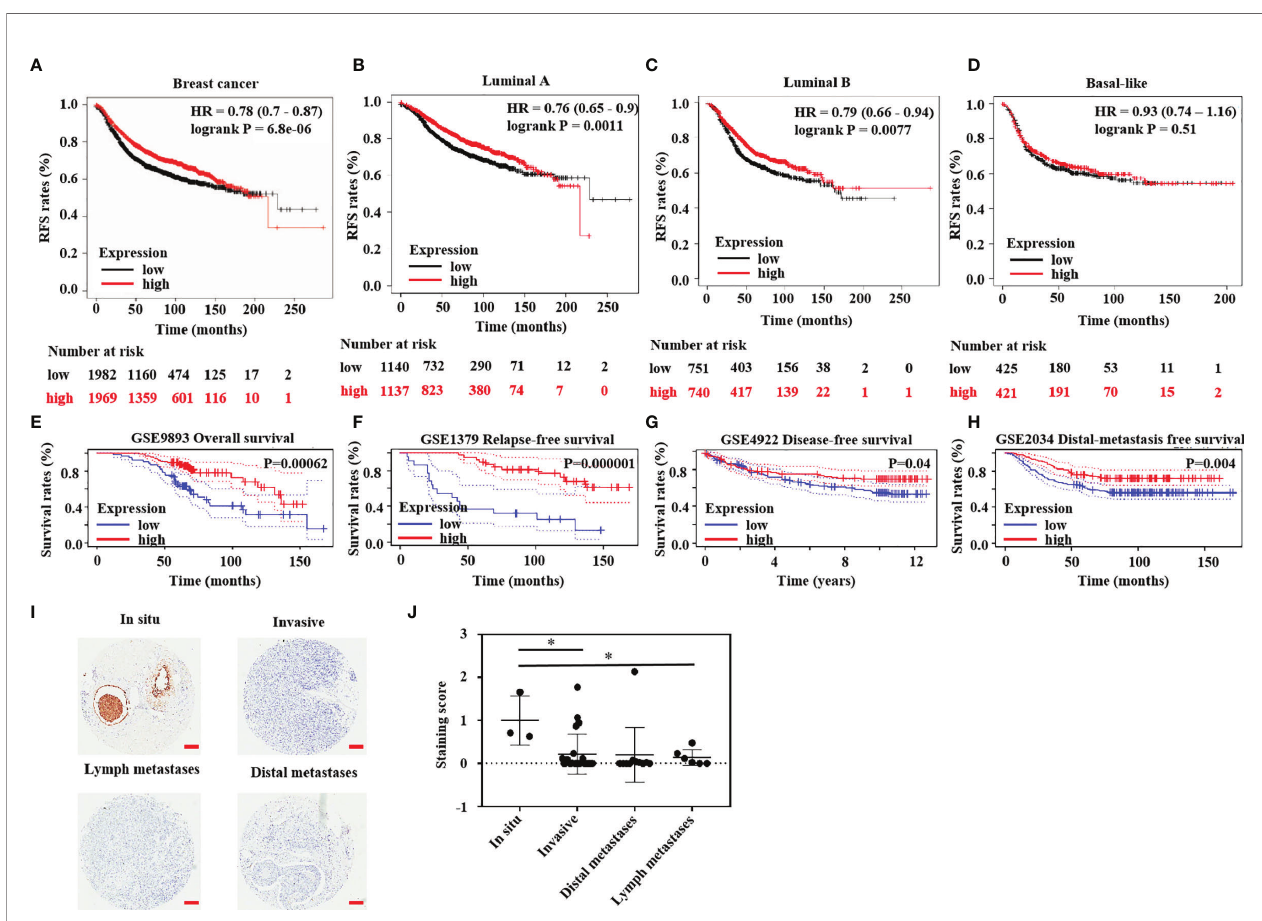
FIGURE 1 | HTR6 had a potential role in human breast cancer. (A) Lower expression of HTR6 was correlated with lower RFS in breast cancer patients (n = 3951); Lower expression of HTR6 was correlated with (B) lower RFS in patients with Luminal A breast cancer and (C) Luminal B breast cancer; But not in (D) patients with Basal-like breast cancer. (E – H) Lower expression of HTR6 was correlated with lower OS, RFS, distal metastasis free survival rate, and disease free survival rate in breast cancer patients. (I, J) The expression of HTR6 was reduced in invasive breast cancer and metastases versus breast cancer in situ, and “ * ” indicated p value <